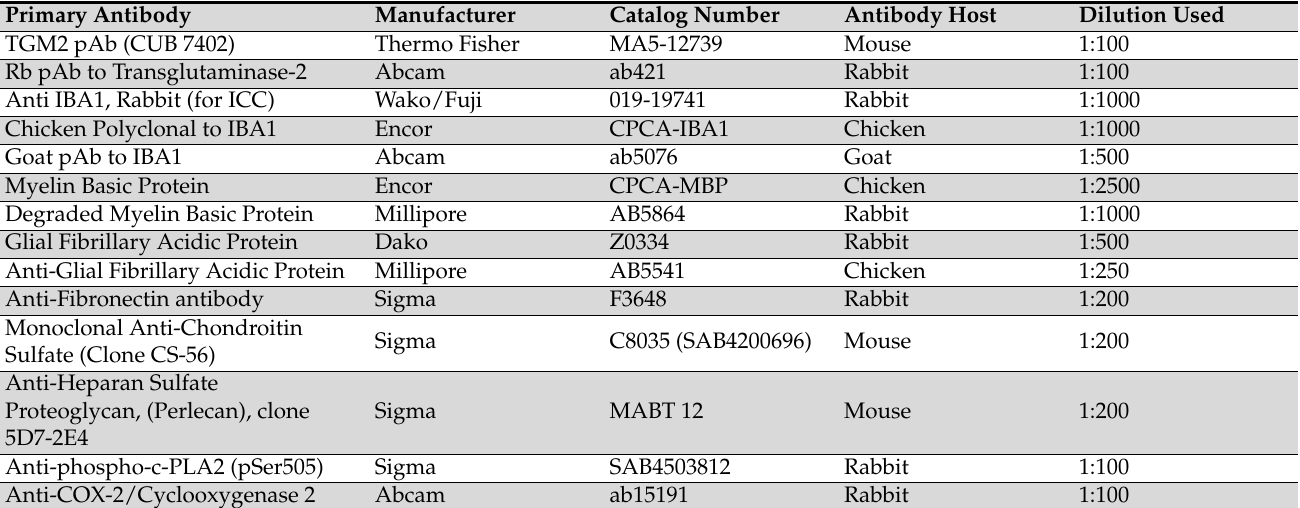
Reagents: Table 2 shows the list of different primary antibodies, their source, and the dilutions that were employed in the study for immunohistochemistry. Table 2. Primary antibodies used for